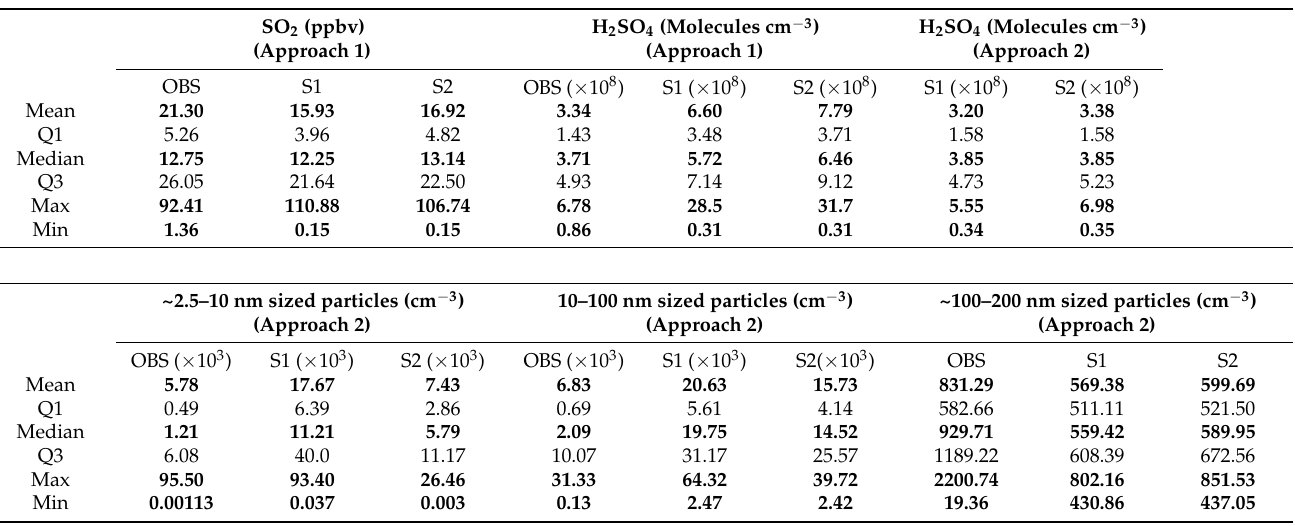
Figure 2. Vertical ( a ) and horizontal ( b ) tracks of the ATR-42 ETNA13 flight (STRAP project) showing the measured SO 2 (ppbv) concentrations. In addition to ( b ), the sub-panels in ( c ) illustrate the three distinctive legs (flight parts) of the aircraft’s trajectory (see Section 2.3 for more details). The black lines are geographical borders of the Sicily Island, Italy. Table 3. Statistical comparisons of measured and simulated key species concentrations in S1 and S2 (Approaches 1 and 2 are described in detail in Section 2.3 and